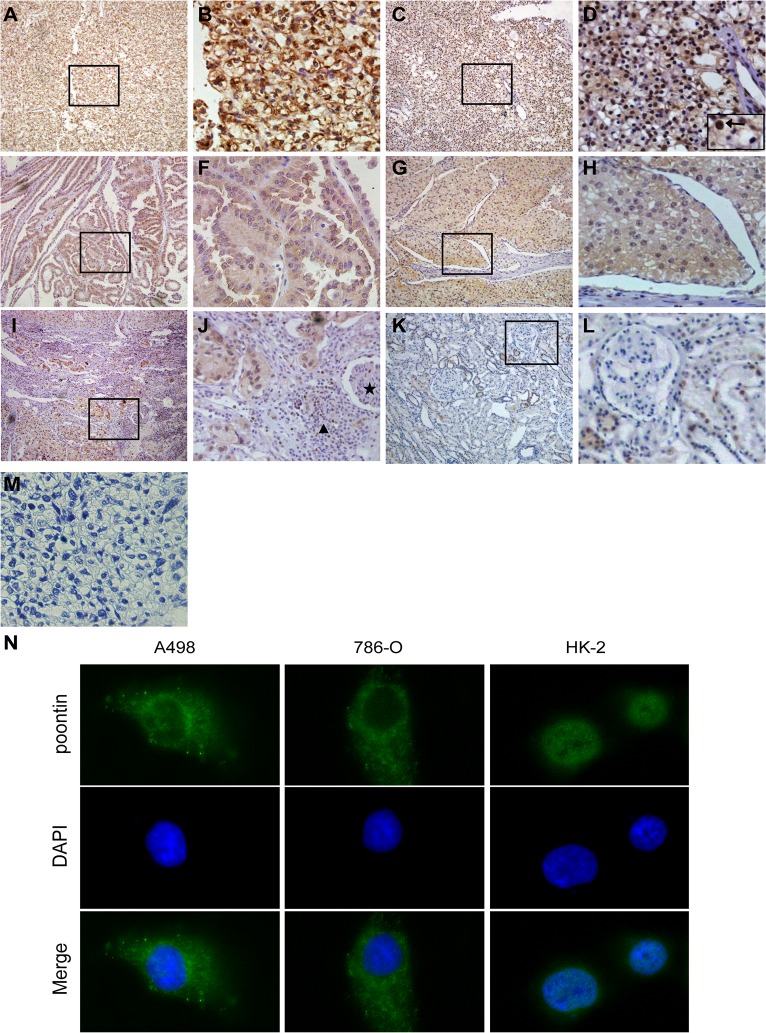
Immuno staining of pontin in RCC surgical specimens and cell lines.Strong cytoplasmic staining of pontin in clear cell RCC (A and B), papillary RCC (E and F), and chromophobe RCC (G and H). Strong nuclear staining of pontin in clear cell RCC (C and D, arrow shows the cells with a strong nuclear staining). Strong cytoplasmic staining of pontin in the tumorous invasive margin of clear cell RCC, while no pontin staining or predominantly nuclear pontin staining in tumor adjacent renal tissues (I and J, ★: glomerulus of the tumor adjacent renal tissues; ▲: infiltrating lymphocytes). Diffuse pontin staining in the proximal tubules of normal renal tissues (K and L). Negative control of clear cell RCC (M). Subcellular localization of pontin protein in RCC cell lines A498, 786-O and normal renal epithelial cell line HK-2 detected by fluorescent immunocytochemical analysis (N). Magnification: A, C, E, G, I, K: ×100; B, D, F, H, J, L, M: ×400 and N: ×600.